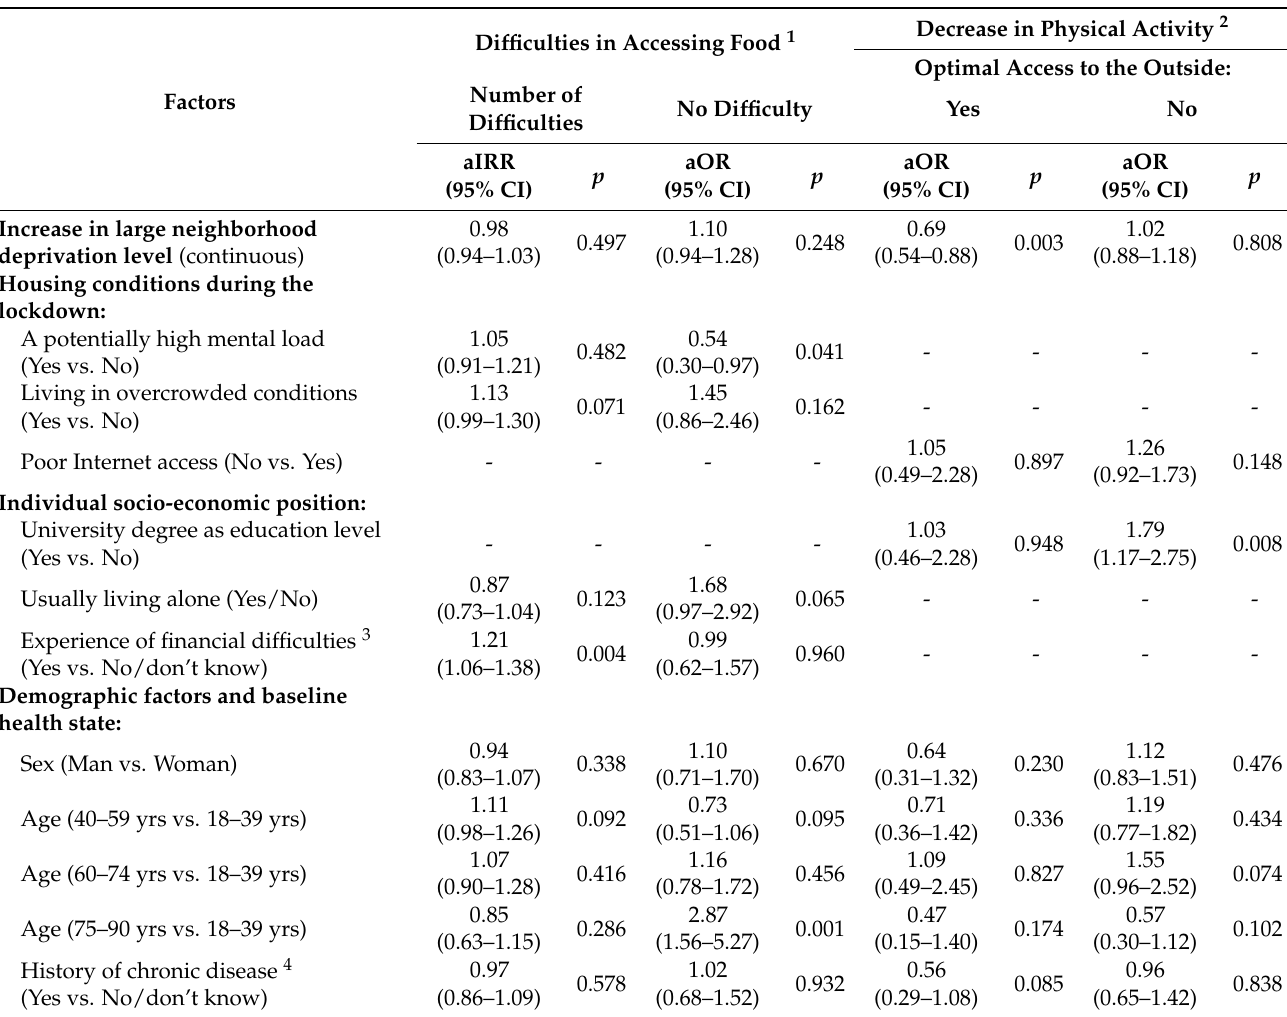
Table 5. Factors independently associated with nutrition endpoints in the adult population during the COVID-19 lockdown (R é -Conf-ISS cross-sectional study: Reunion Island, 13 May and 22 July 2020)—fully adjusted multivariable models